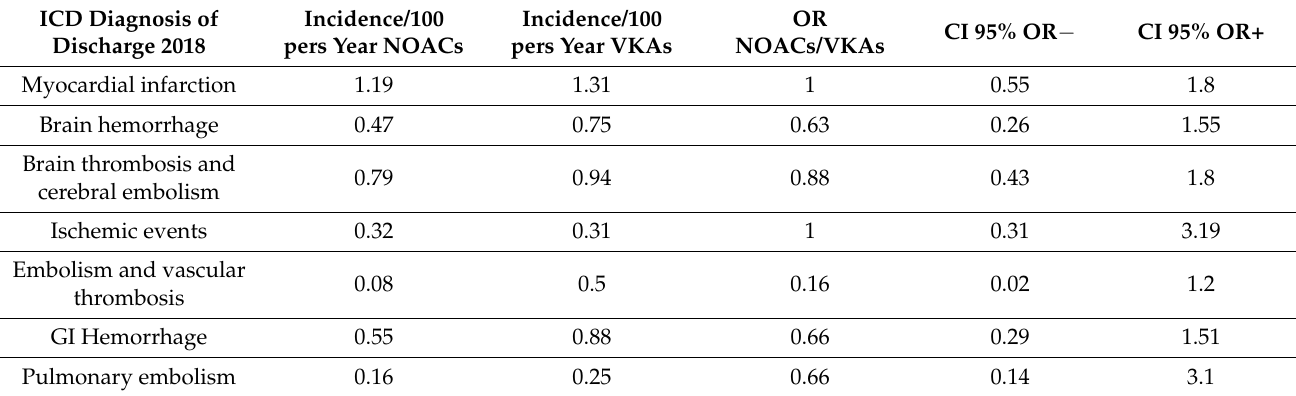
Table 6. Odds ratio (NOACs vs. VKAs) for major discharge diagnoses